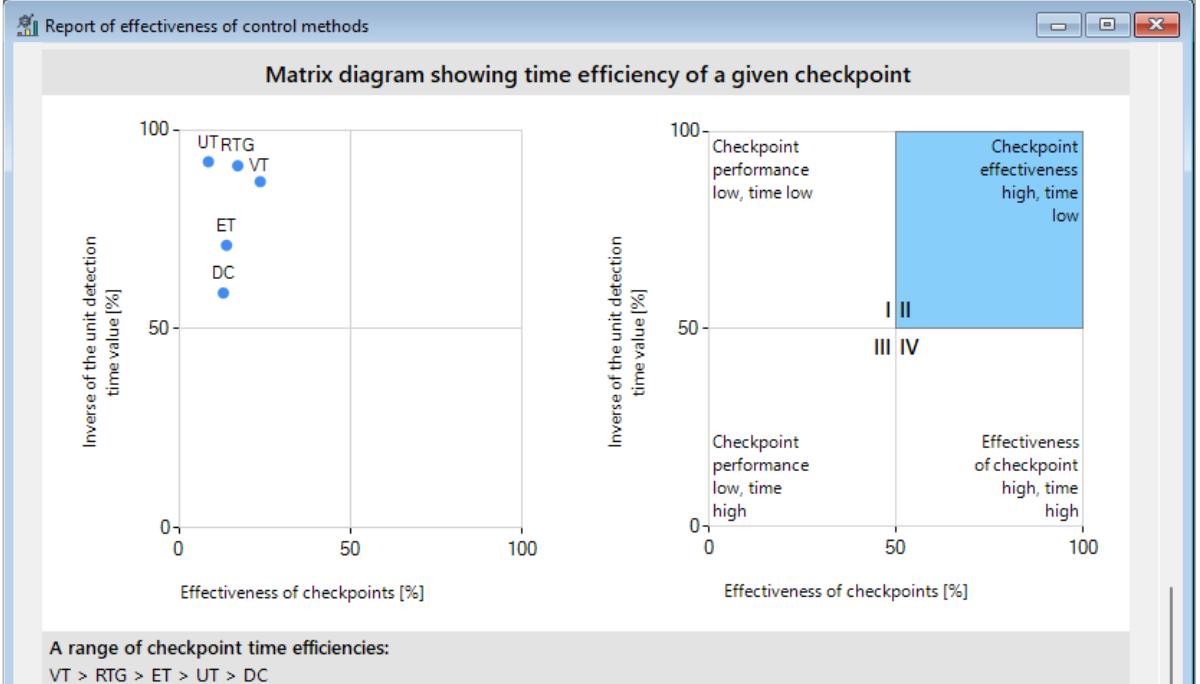
Figure 9. Part four of the control methods efficiency report — analysis of the level of time efficiency of detection methods.